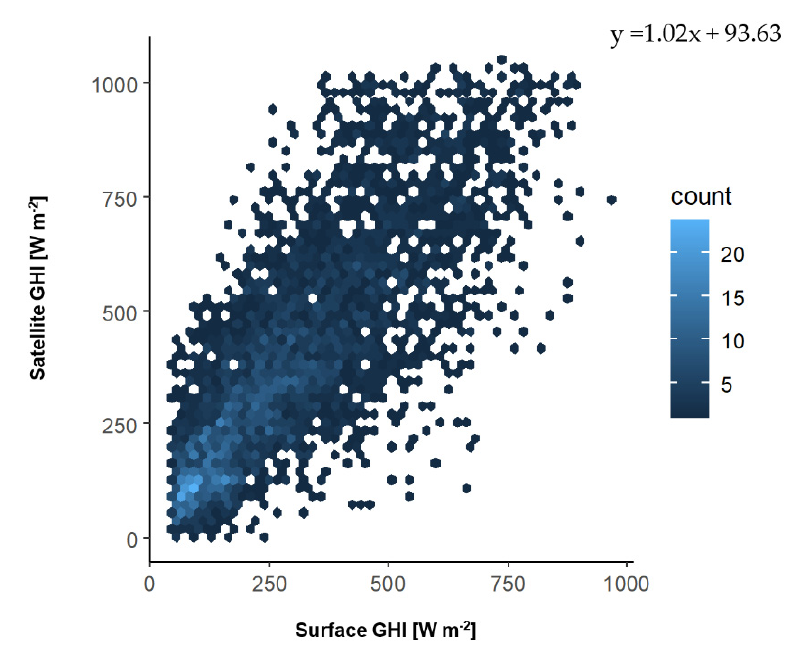
Figure 5. Scatterplot of hourly surface vs. satellite GHI profiles.